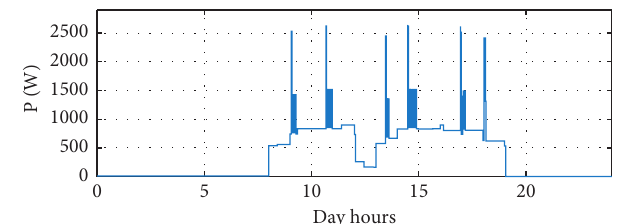
Figure 11: Generated power, by the used panels, during a typical day of January in Jeddah.